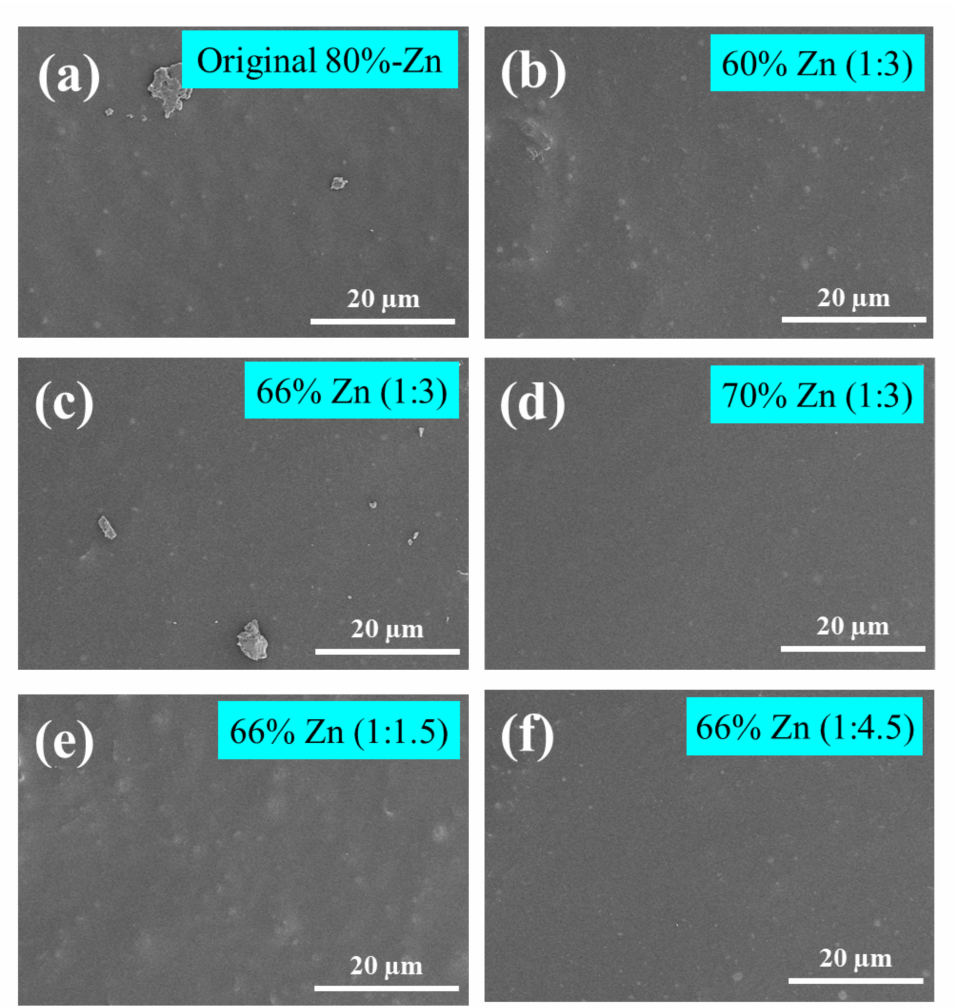
Figure 7. The SEM images of ZRP coatings with different zinc content and replacing ratios of PPy/SCP particles: ( a ) original 80% Zn, ( b ) 60% Zn (1:3), ( c ) 66% Zn (1:3), ( d ) 70% Zn (1:3), ( e ) 66% Zn (1:1.5) and ( f ) 66% Zn